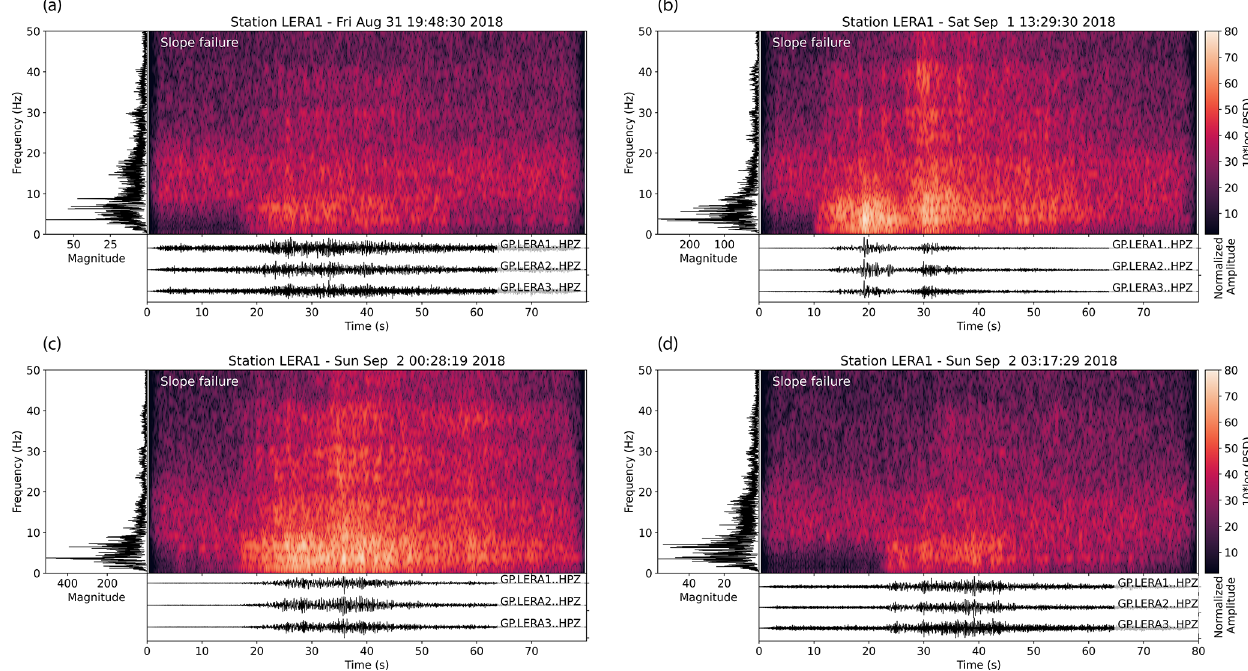
Figure A1. Seismic signals, spectrograms, and spectra of four additional slope failure events in 2018 used for training. Spectrograms have been computed with a window length of 128 samples, an overlap of 120 samples, and an FFT length of 2048.